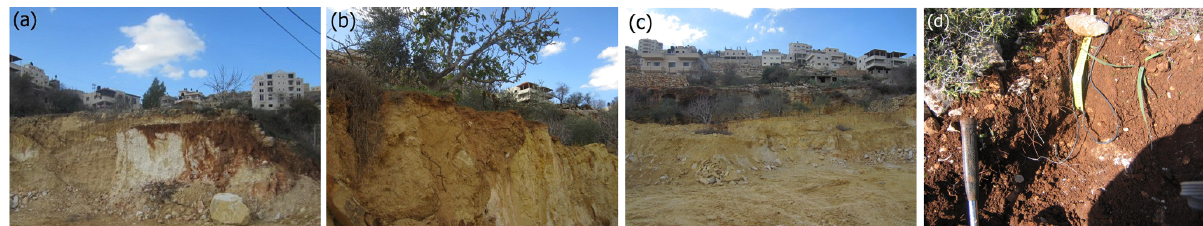
Figure A2. Soil cover. Soil covering marly limestone (bottom Hebron/top Yatta formation), with some white caliche-type “Nari” crust (a, b,